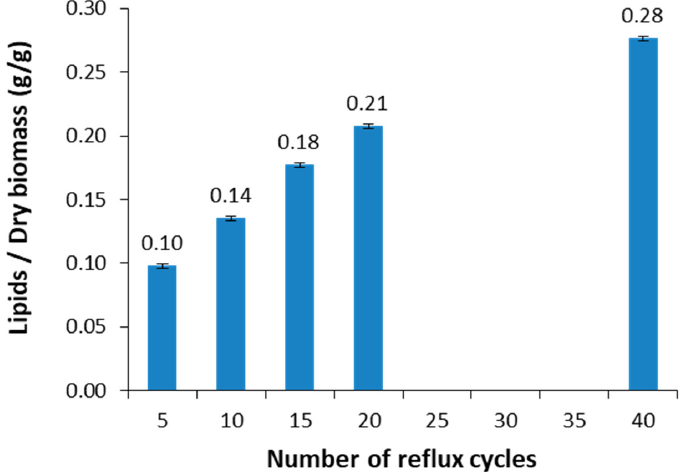
Figure 6. Lipid yield (L/DB, g/g) compared to control L/DB versus the number of reflux cycles during Soxhlet extraction experiments. MeOH/Hex ratio was 3:5 and dry biomass/solvent was 40. Error bars indicate standard deviation. Number of replicates (N = 2).